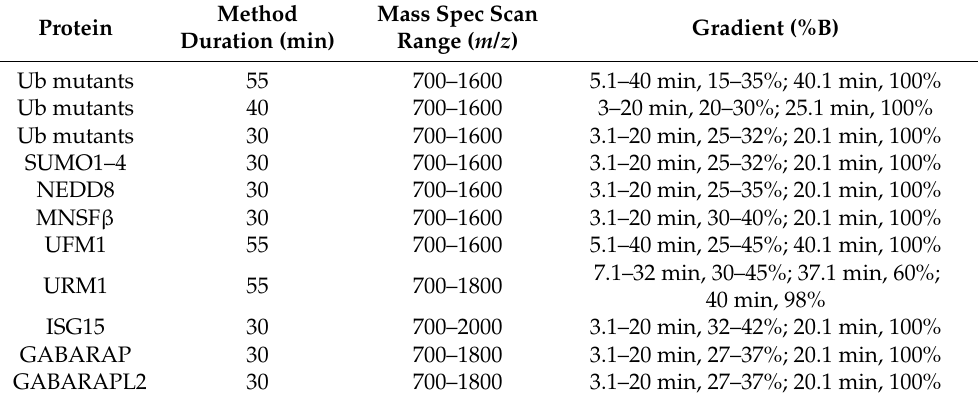
Table 3. LC-MS method